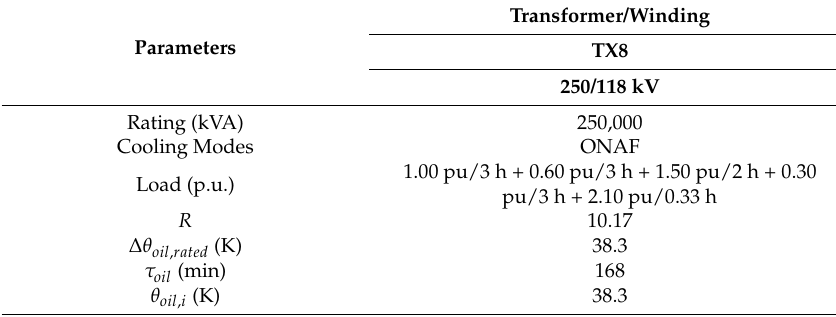
Table 2. Input parameter for TOT thermal model for step loading [1,5].